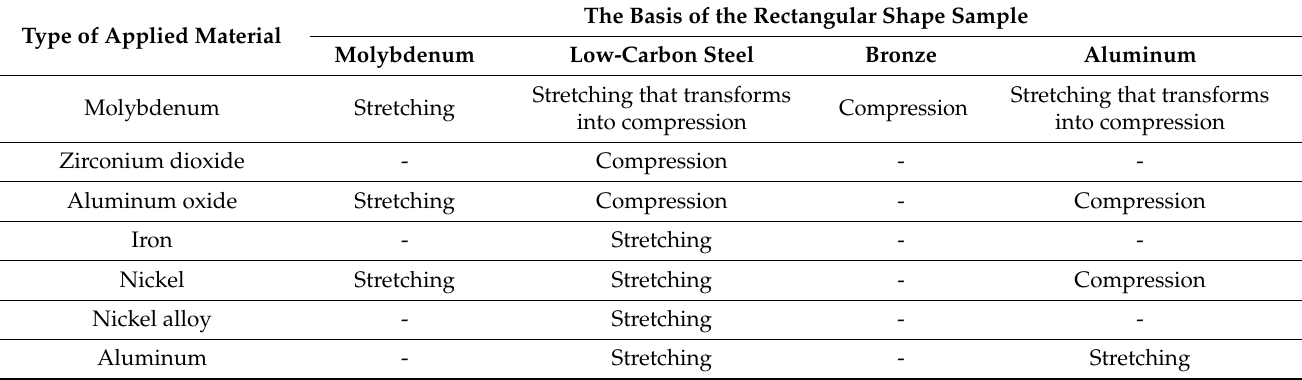
Table 3. Change in the nature of voltage depending on the type of coating material and